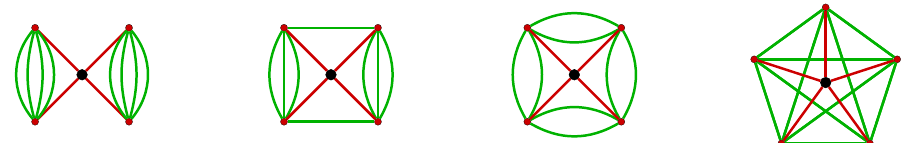
Figure 1 . From left to right: diagrammatic representation of double-trace melonic, melonic, necklace and simplicial interaction vertex graphs for rank- 4 fields. Green half-edges indicate the pairwise convolution of non-local group arguments g a while red ones represent local variables labelled with i momenta k . Red vertices correspond to fields Φ( φ , g , X i ) while black ones represent point-like i i interactions with respect to φ